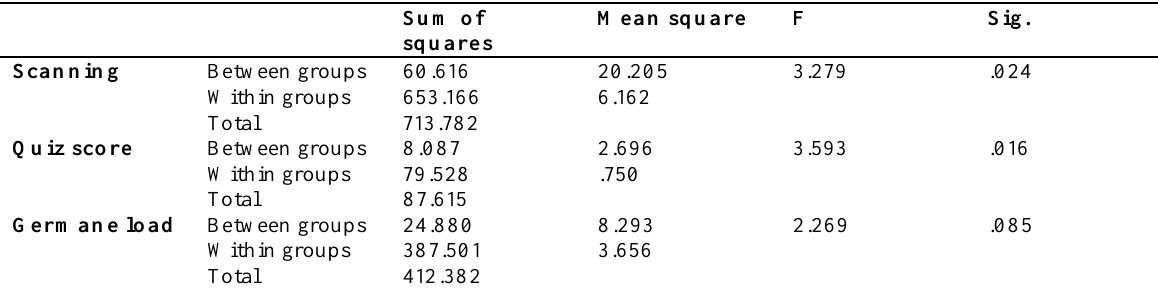
Sum of Mean square F Sig. squares